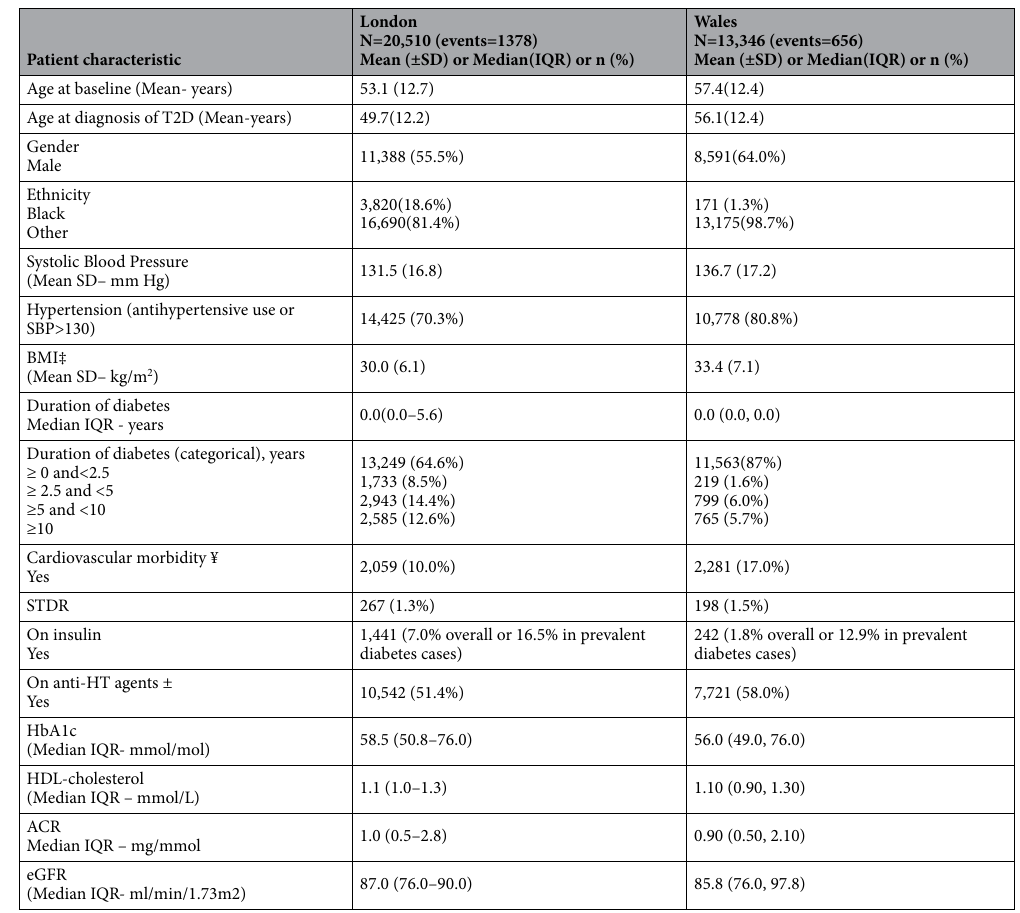
Table 1. Baseline characteristics of the study cohort. T2D type-2 diabetes; eGFR estimated glomerular filtration rate; Anti‑HT anti-hypertensive; CVD cardiovascular disease; HbA1c haemoglobin A 1c ; STDR sight- threatening diabetic retinopathy; BMI Body Mass Index; HDL High-density Lipoprotein; ACR Albumin: Creatinine ratio; IQR Interquartile range. ¥CVD includes Myocardial Infarction (MI), stroke, Atrial Fibrillation (AF), Heart failure (HF), Coronary Heart Disease (CHD) and Peripheral Vascular Disease (PVD). ± Anti- hypertensive agents include Angiotensin receptor blocker/Angiotensin-converting enzyme (ARB /ACE)